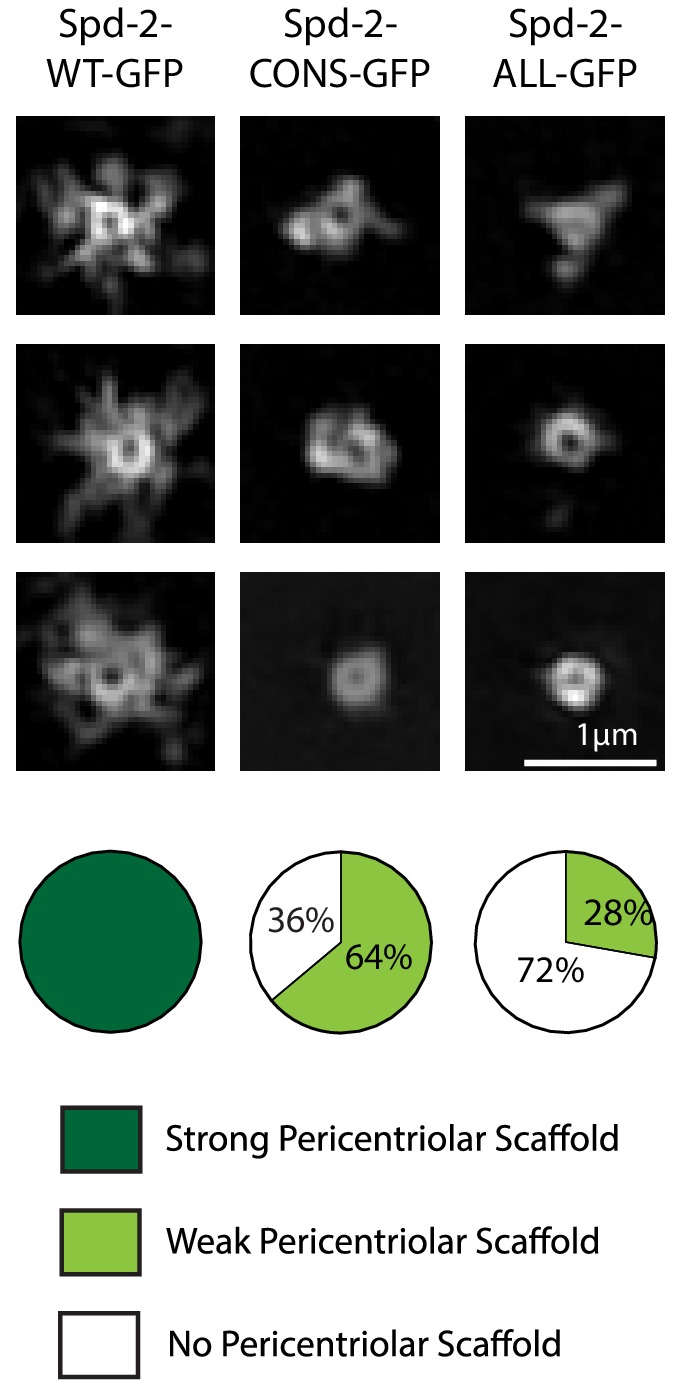
Spd-2-CONS and Spd-2-ALL do not efficiently assemble a PCM scaffold.Micrographs show 3D-SIM images of individual centrosomes from Spd-2 mutant embryos expressing WT Spd-2-GFP, Spd-2-CONS-GFP or Spd-2-ALL-GFP (as indicated). Pie charts quantify the percentage of centrosomes that were scored qualitatively as having a strong (dark green), weak (light green) or no (white) pericentriolar scaffold (n = 36, for each genotype, respectively). In this, and all other SIM experiments, images were only included in the analysis if the reconstruction was deemed of sufficient quality by SIM-Check (Ball et al., 2015) (see Materials and methods for a full explanation of image quality control). All centrosomes were imaged in mid-late S-phase when the centrosomal levels of Spd-2 are maximal (see Figure 8). All scorings were performed blind by researchers not involved in the data acquisition.10.7554/eLife.50130.019Figure 4—source data 1.Figure 4 source data, results from blind scoring.